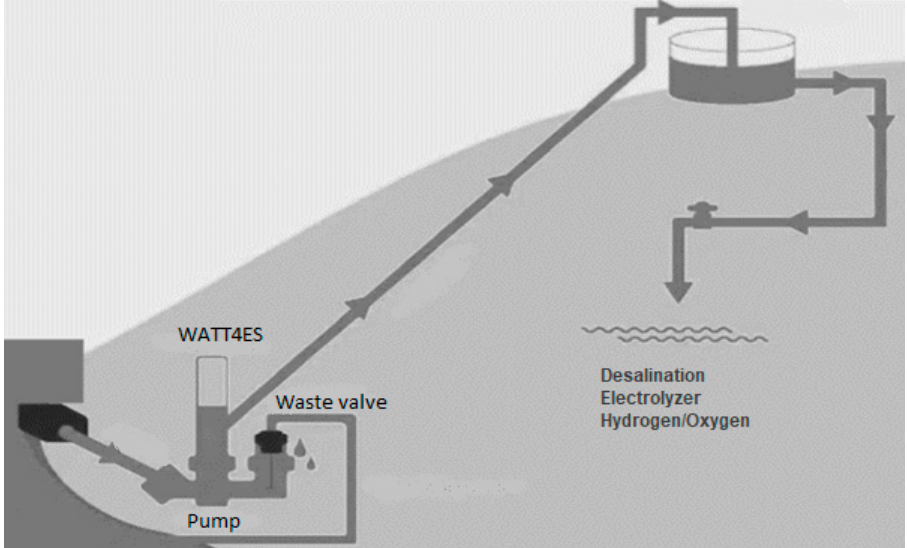
Figure 4. Hydram